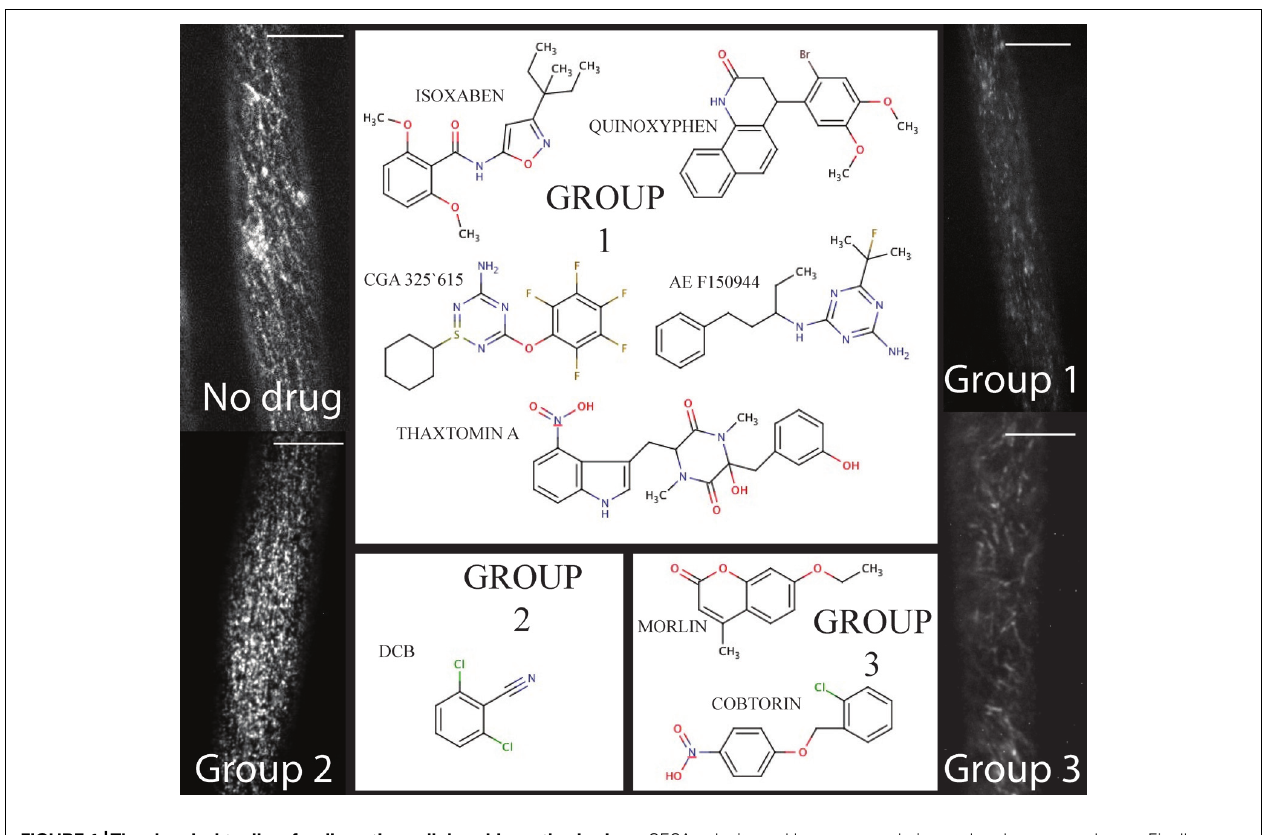
FIGURE 1 |The chemical toolbox for dissecting cellulose biosynthesis via live-cell imaging. Group 1 includes compounds such as isoxaben and thaxtomin A that induce clearance of CESA from the plasma membrane. By contrast, Group 2 is comprised of DCB, which causes a syndrome of reduced